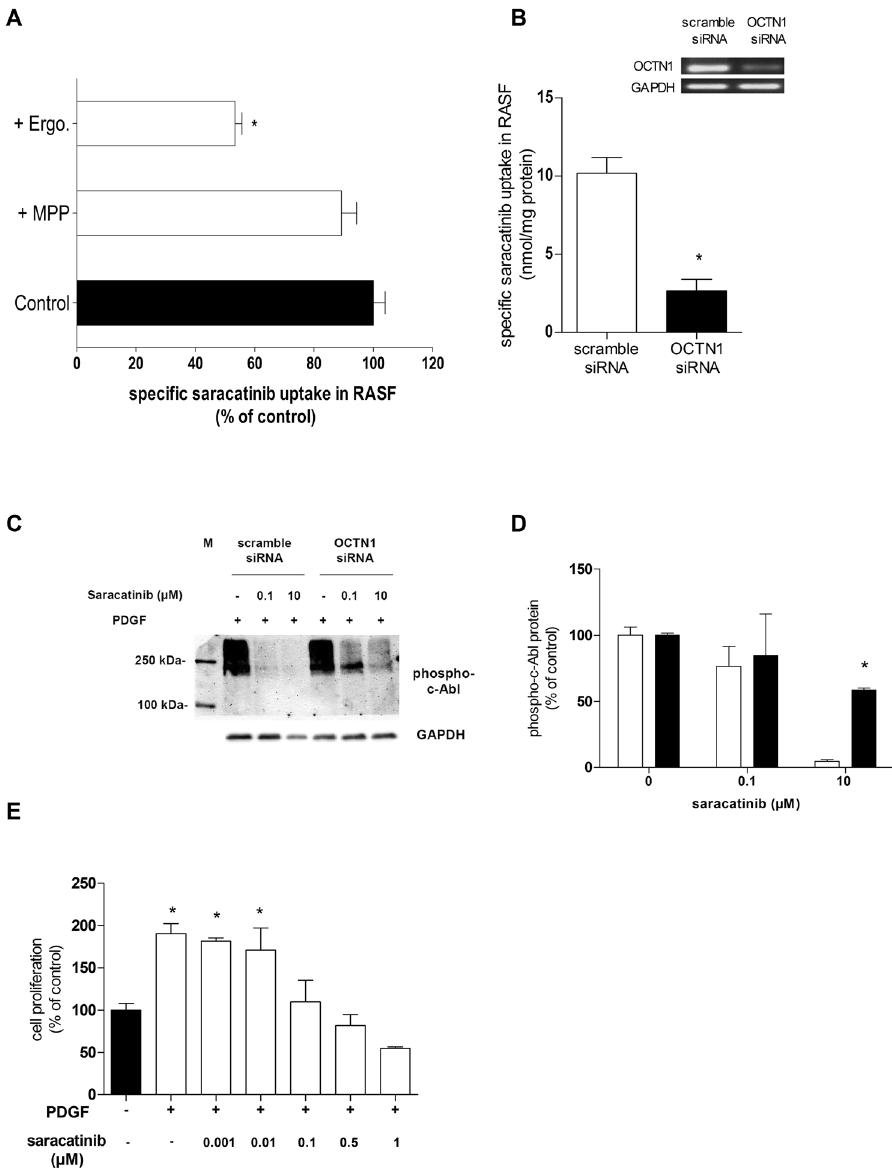
Figure 3. Dependence of saracatinib uptake and biological function on hOCTN1 in hRASF. ( A ) Saracatinib uptake (10 µ M) by RASF under inhibition of OCT1-3 by 20 µ M MPP + or OCTN1 by 40 µ M ergothioneine (Ergo.), respectively (n = 8–14). ( B ) Saracatinib uptake by RASF 24 h after transfection with non-targeting (scramble-siRNA, white column) or OCTN1 (OCTN1-siRNA, black column) siRNA. Data are shown as mean ± SEM of three independent experiments. ( B , insert) Transcriptional expression levels of OCTN1 in RASF 24 h after transfection with scramble-siRNA or OCTN1-siRNA determined by PCR (a whole gel of PCR analysis for detection of siRNA-transfection effects is shown as Supplemental material Fig. 1). ( C ) Representative Western blot analysis of PDGF induced (10 ng/ml) c-Abl phosphorylation with or without ( − ) saracatinib incubation for 10 min in scramble-siRNA- and OCTN1-siRNA transfected RASF of one from three independent experiments. M indicates the lane with molecular weight markers. As loading control was used GAPDH, which has a lower molecular weight than phosphorylated c-Abl (phospho c-Abl). ( D ) Protein expression levels of phospho-c-Abl upon PDGF (10 ng/ml) and saracatinib incubation (0, 0.1, and 10 µ M) for 10 min in scramble-siRNA- (white column) and OCTN1-siRNA (black column) transfected RASF (n = 3). Asterisks * indicate significant difference compared to scramble-siRNA-RASF incubated with 10 ng/ml PDGF and 10 µ M saracatinib, calculated by two-tailed Student’s t-test for unpaired experimental values. ( E ) Effects of saracatinib on PDGF-induced proliferation of cultured RASFs. RASFs were incubated for 18 h with 10 ng/ ml PDGF in the presence of the indicated saracatinib concentrations. Cell proliferation was determined by counting the number of SFs from three different RA patients. Data are shown as mean ± SEM. Asterisks * indicate significant differences compared to control with PDGF, calculated by one-way ANOVA followed by Dunnett’s test ( P <